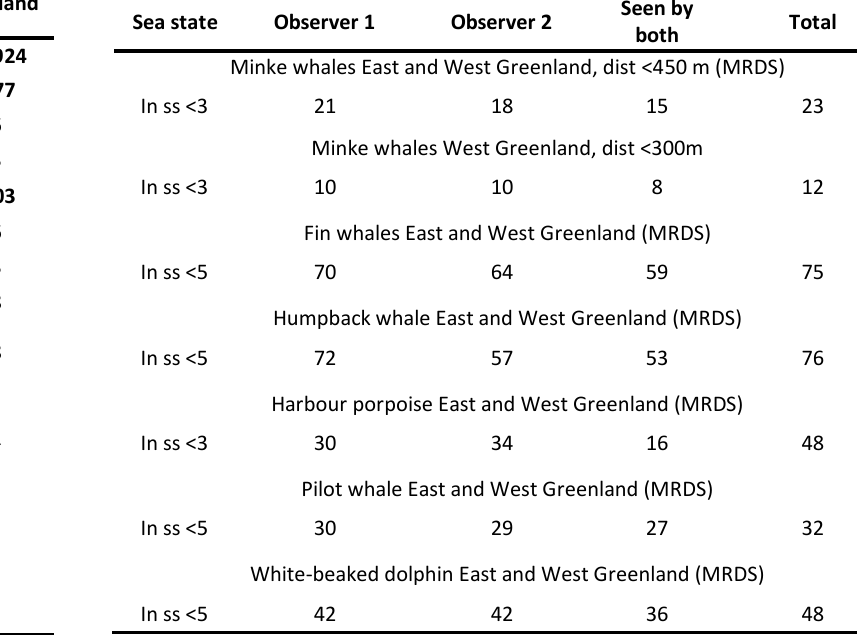
Table 4. Area of strata, effort and sightings. Table 3. Number of sightings seen by each observer and the number of duplicates (seen by both observers). The ‘Total’ column shows the number of sightings seen by observer 1 and observer 2 with the sightings seen by both removed. CV ’s are given in parenthesis.